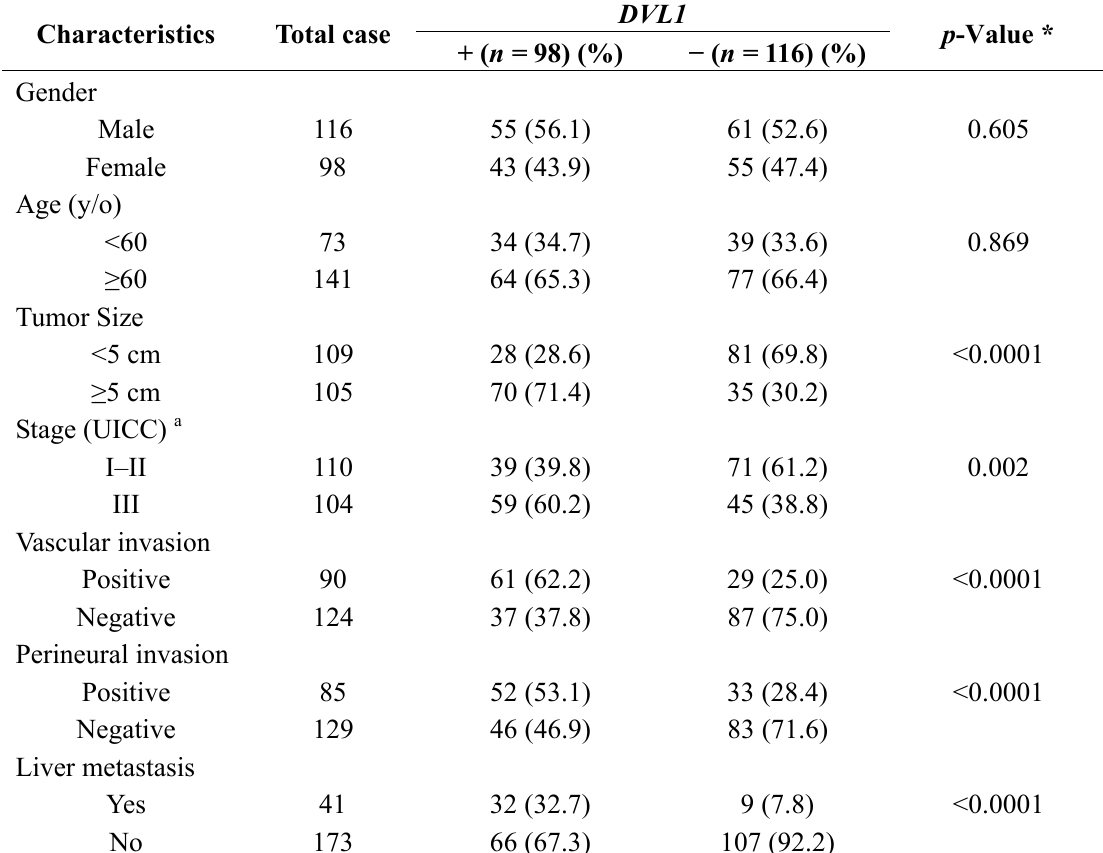
Table 3. The relationship between clinicopathological features and DVL1 mRNA overexpression in 214 postoperative colorectal cancer